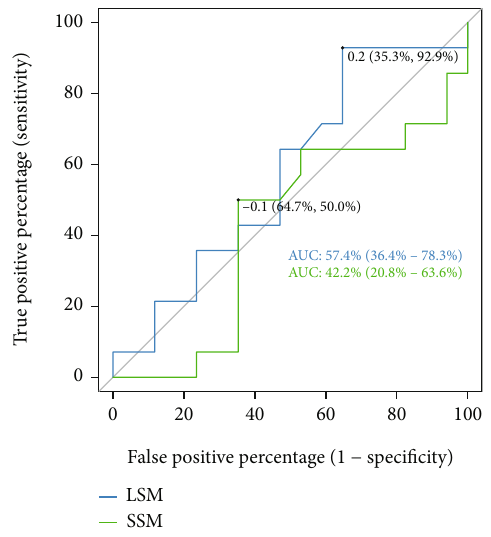
Figure 8: The AUC-ROC results for LSM and SSM in diagnosis of responder status in comparison to HVPG results showed a very poor ability to diagnose a successful NSBB treatment (HVPG =hepatic venous pressure gradient; LSM=liver sti ff ness measurement; SSM=spleen sti ff ness measurement). Table 3: Binary logistic regression analysis of elastography results of both the liver and spleen, BMI, age, and MELD score did not show any signi fi cant relationship with HVPG-de fi ned response (BMI =body mass index; HVPG =hepatic venous pressure gradient; LSM =liver sti ff ness measurement; MELD=model of end-stage liver disease; SSM =spleen sti ff ness